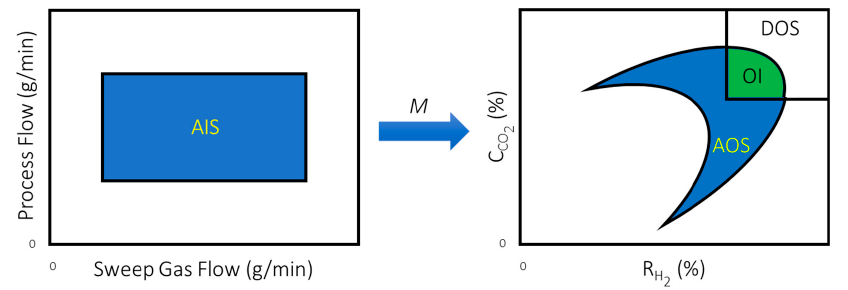
Figure 3. Schematic of the process operability concept. The fraction of the DOS covered by the green region would correspond to the operability index (OI) for the design.